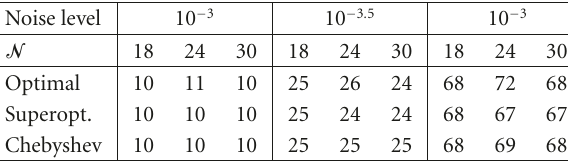
Table 2: Number of iterations varying N for Mask 2, with τ = 0 . 1